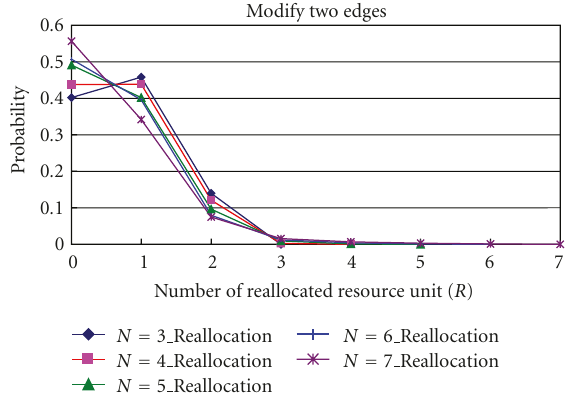
Figure 10: Probability density function of R : two-edge modifica- tions.